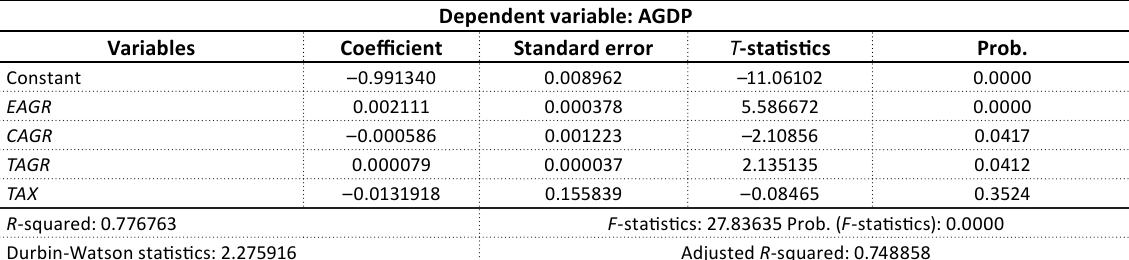
Source: Authors’ compilation